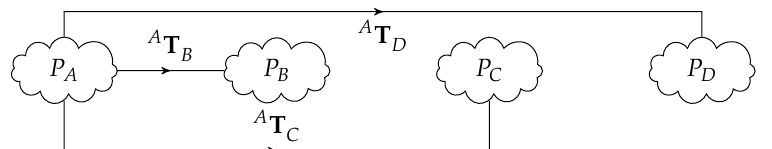
Figure 2. Example of four distinct point clouds showing the transformations of B, C, and D relative to frame A. See the set-up in Figure